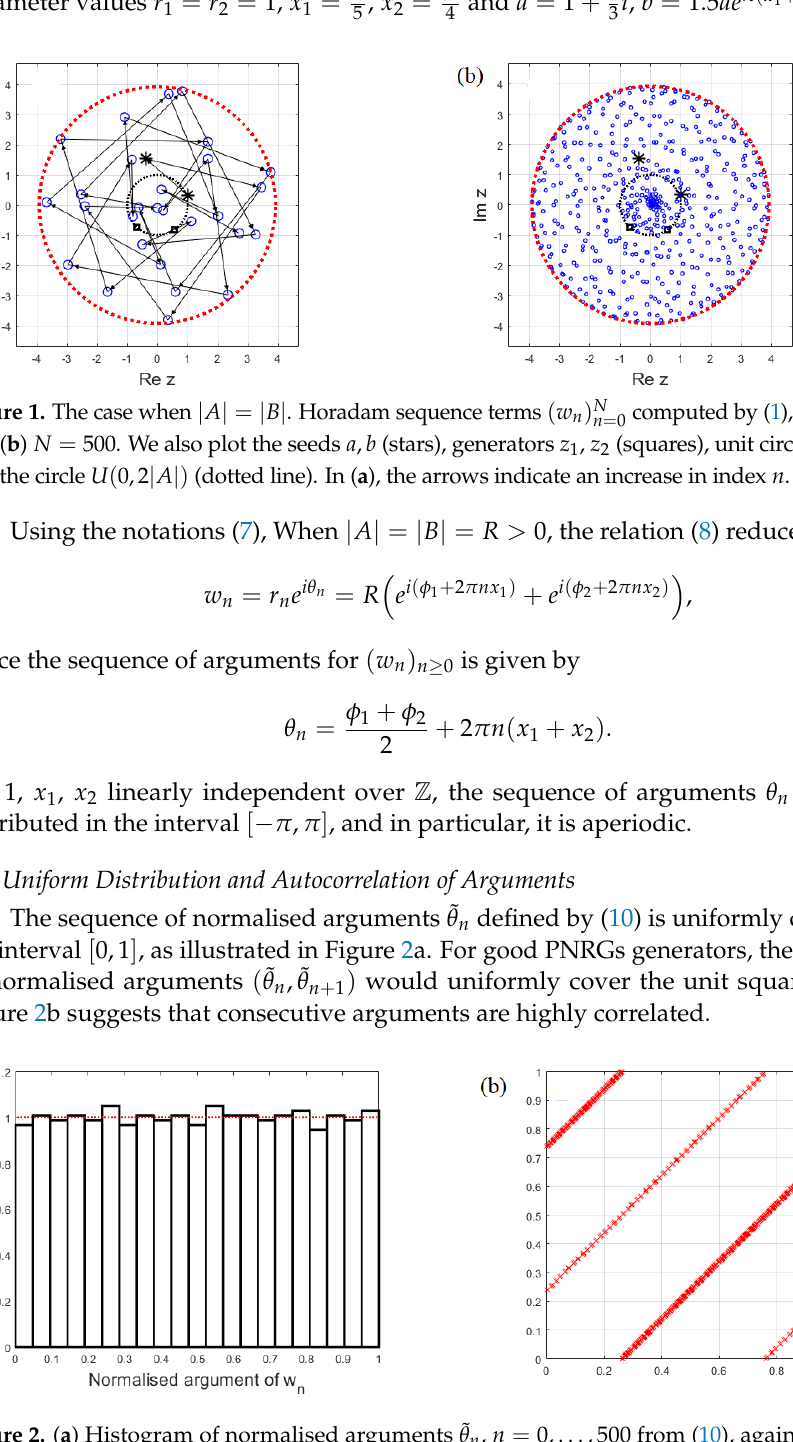
Figure 2. ( a ) Histogram of normalised arguments ˜ θ n , n = 0, . . . ,500 from (10), against the uniform density (dotted line); ( b ) Plot of ( ˜ θ n , ˜ θ n + 1 ) (crosses), n = 0, . . . ,500, for the sequence in Figure